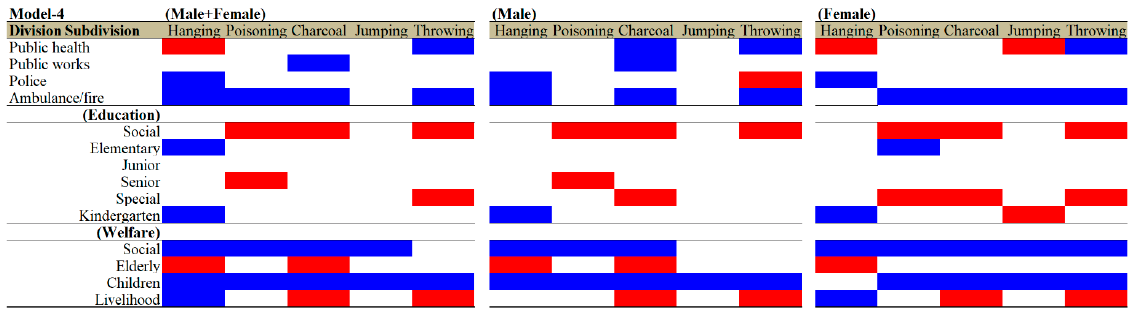
Figure 5. Impacts of expenditure of four major divisions (public health, public works, police and ambulance/fire) and subdivisions of education and welfare per capita on suicide mortalities by five major suicide means (hanging, poisoning, charcoal burning, jumping and throwing suicide) of both gender (males plus females), males and females between 2009 and 2018 using fixed- or random-effect analyses of hierarchal linear regression with robust standard error. Blue and red columns, significant factors for decreasing and increasing suicide mortalities.